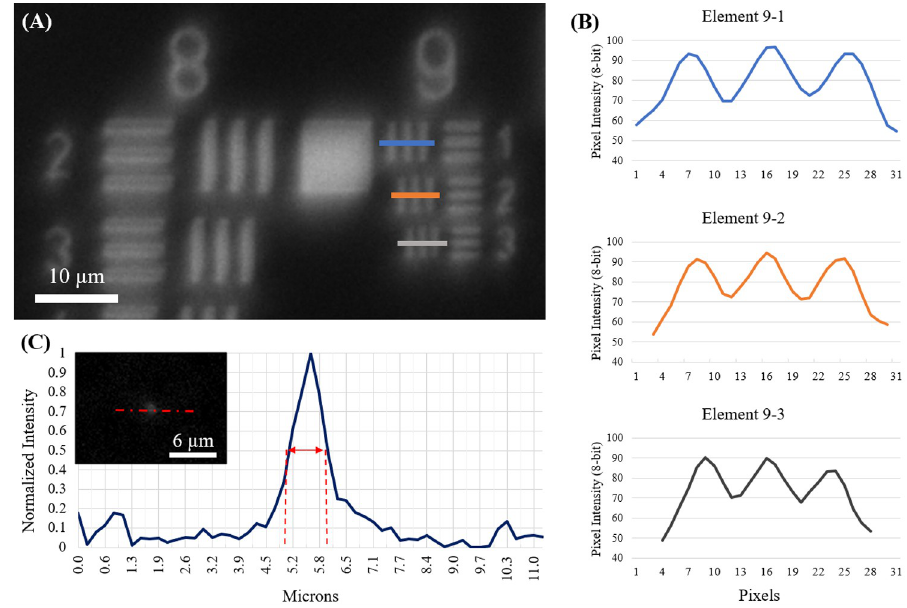
Fig 3. (A) Image of 1951 US Air Force Target captured using the portable microscope. (B) Profiles from rectangular sections taken across elements 9–1: 0.98 μ m; 9–2: 0.87 μ m; and 9–3: 0.78 μ m are shown at right. (C) Point spread function of the microscope measured using averaged profiles through sub-resolution fluorescent features